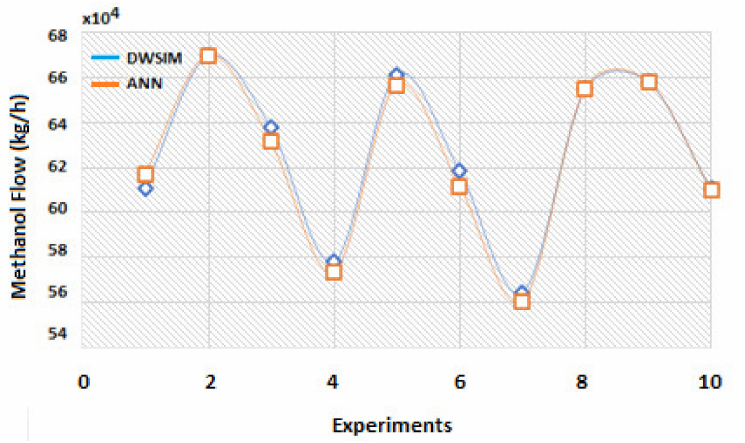
Figure 10. Comparison between observations (DWSIM-blue) and predictions of ANN (orange) methanol